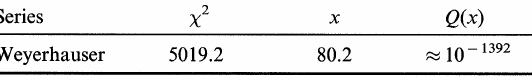
corresponding probability P(x’ > x)